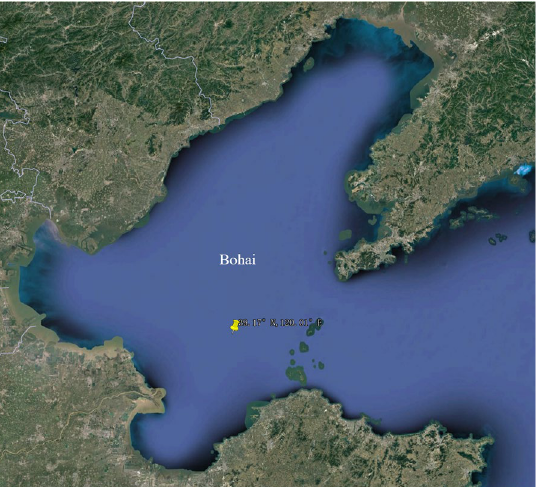
Figure 6. Bohai sea area from google earth. Imagery/Maps data: Google Earth, TerraMetrics and TMap Mobility 26